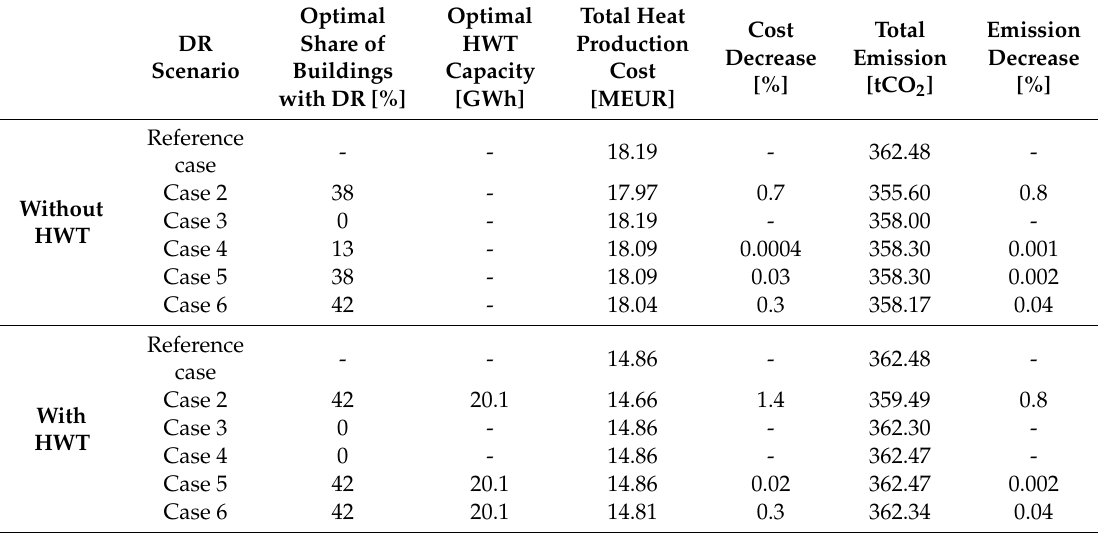
Table 3. E ff ect of DR in the costs and emissions compared to the reference case.